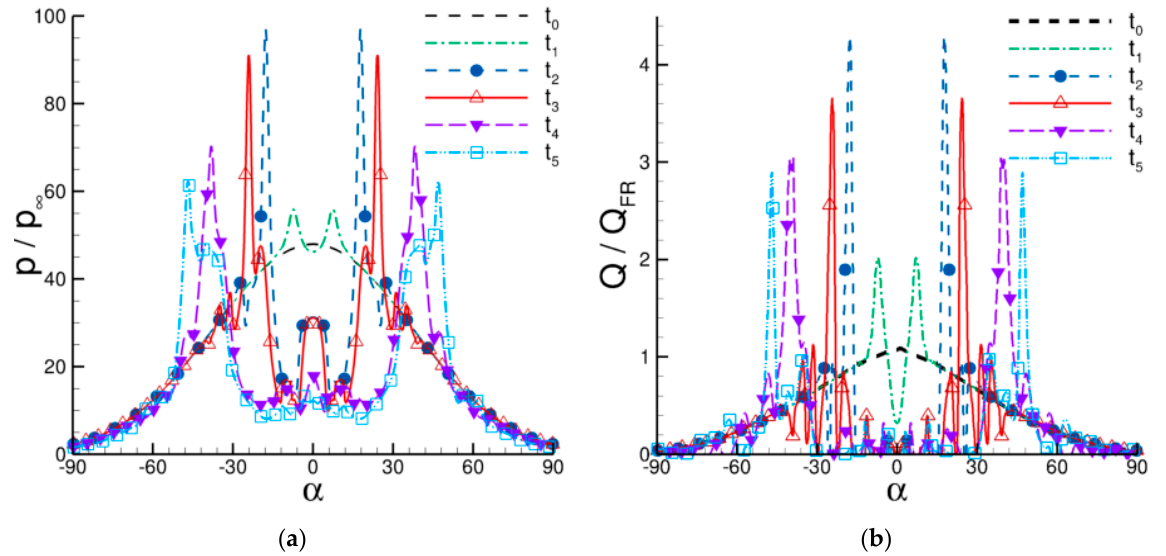
Figure 8. Oscillations of the pressure ( a ) and the convective heat flux ( b ) on the surface, induced by the gas-dynamic interaction of a particle with a shock layer.